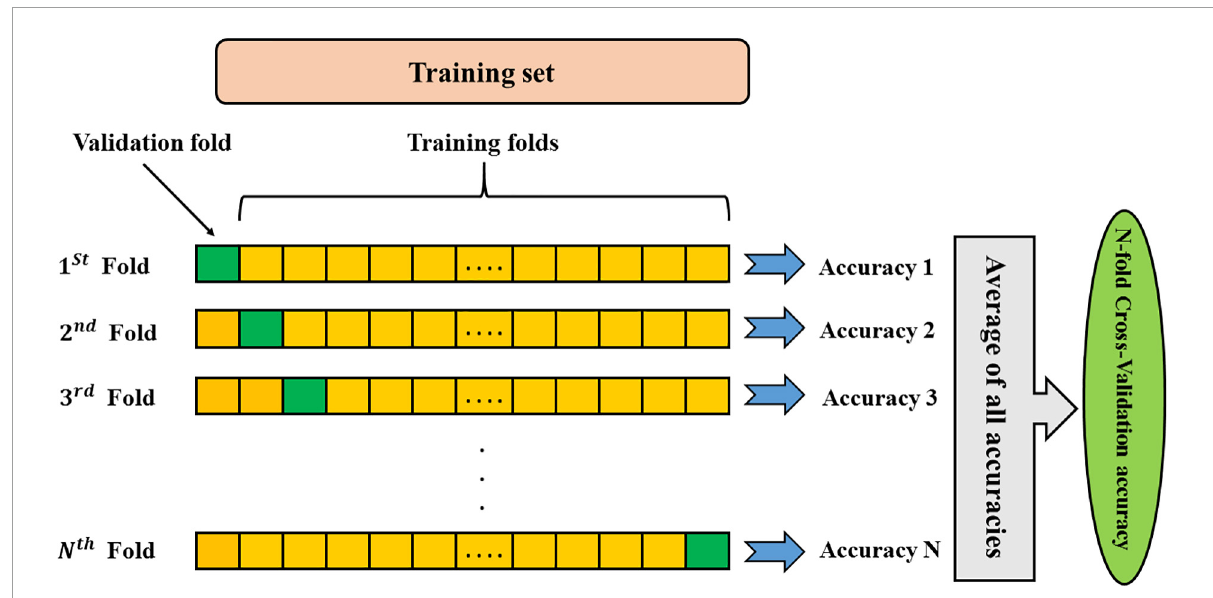
FIGURE2 Schematic representation of K-fold cross-validation method. Data colored as yellow are the training folds, and the green fold is the one that leaved out for the